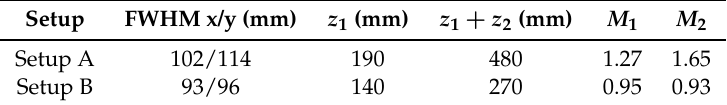
Figure 3. X and Y cross-sections of the measured illuminating beam in the case of Setup A. Table 1. Incident beam parameters (full width at half maximum (FWHM)) for A and B setups. Reconstructed image parameters: distance from the hologram to a particular image and magnifications of the images